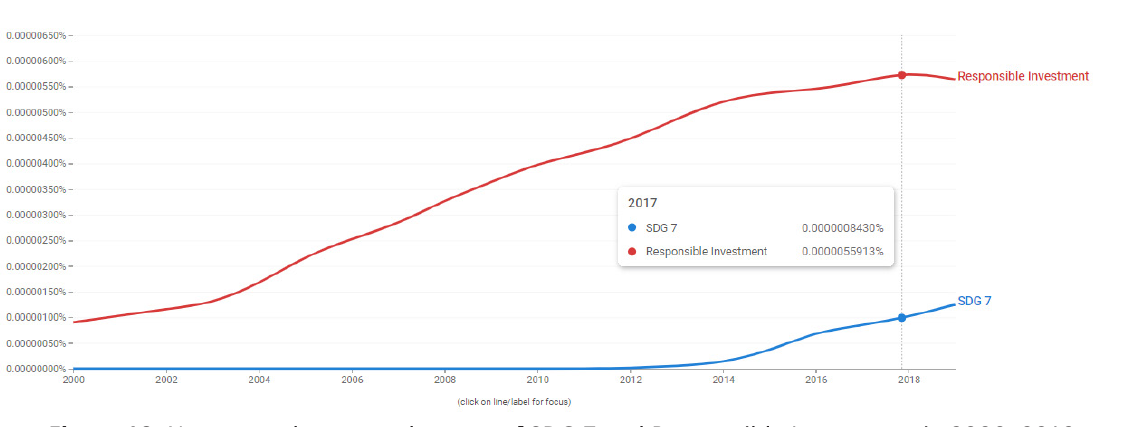
Figure 10. Ngram on the research terms of SDG 7 and Responsible Investment in 2000–2019